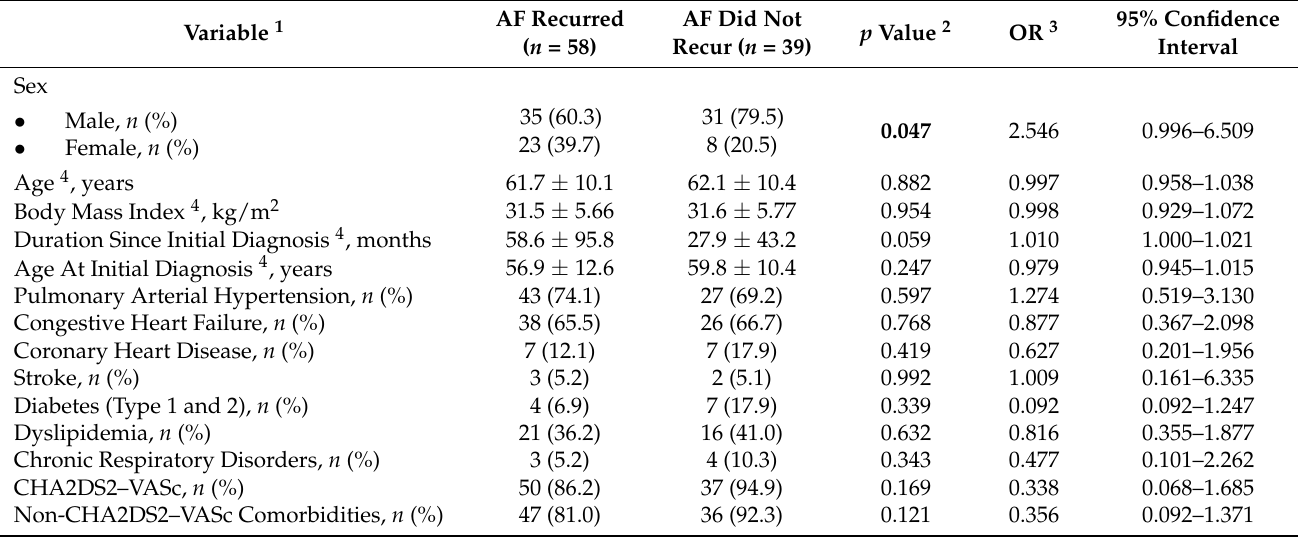
Table 3. Characterization of patients from DCC follow-up for whom AF recurred vs. did not recur.